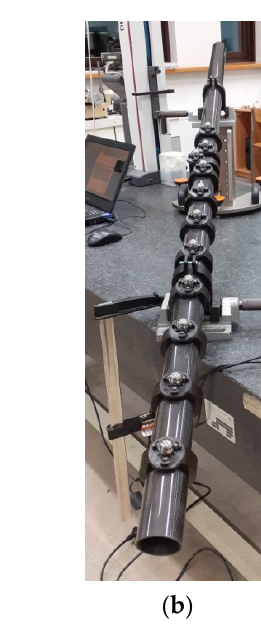
Figure 6. The reconfigurable ball-bar standard: ( a ) the technical drawing; ( b ) real specimen of reference object. Central spheres mounted on sockets along the bar allow the performance of